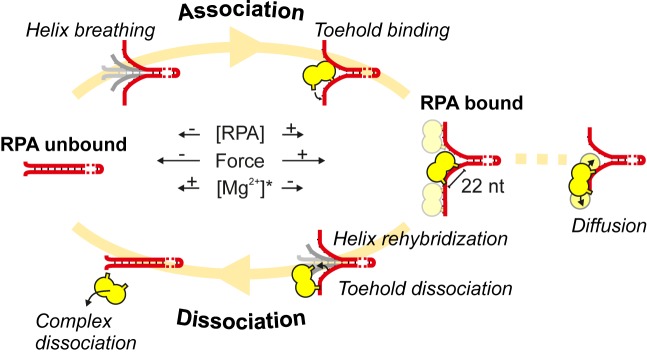
Dynamics of RPA on DNA fork. Initially, Association commences from a RPA unbound DNA fork. Helix breathing exposes small stretches of ssDNA to which RPA attaches via Toehold binding. Further binding occurs in the same manner rendering the ssDNA arms of the fork RPA bound. Individual bound RPA heterotrimers can slide along the ssDNA by Diffusion. Dissociation of RPA is triggered when DNA Helix rehybridization causes Toehold dissociation ultimately leading to Complex dissociation. Further dissociation ultimately reverts the DNA fork to the RPA unbound state. Both competing processes take place continuously, with the balance being controlled by the concentration of RPA, the applied force and (*in the case of hRPA) the Mg2+ concentration. Higher force or RPA concentration favors association, while (for hRPA) more Mg2+ shifts the balance toward dissociation.